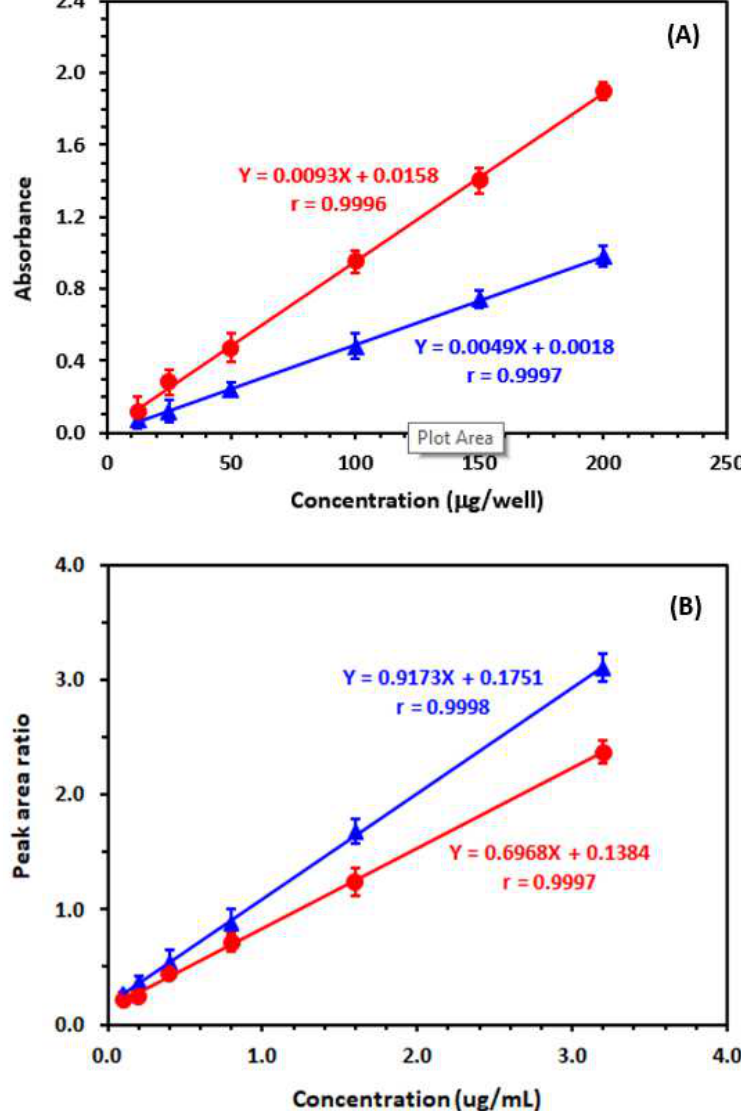
Figure 11. Calibration curves for quantitation of DUV ( (cid:78) ) and SEL ( • ) by MW-SPM ( A ) and HPLC-FD ( B ). Values of absorbance and peak area ratio are mean of 3 determinations ± SD. On the graph, correlation coefficients (r) are provided for each corresponding calibration line along with linear fitting equations.